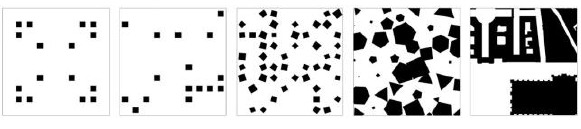
Figure 3 . Sample layout of the different sets. From left to right: Manual; Random 16; Random 49 rotated and scaled, Random full; Milan (Duomo and Galleria Vittorio Emanuele II)